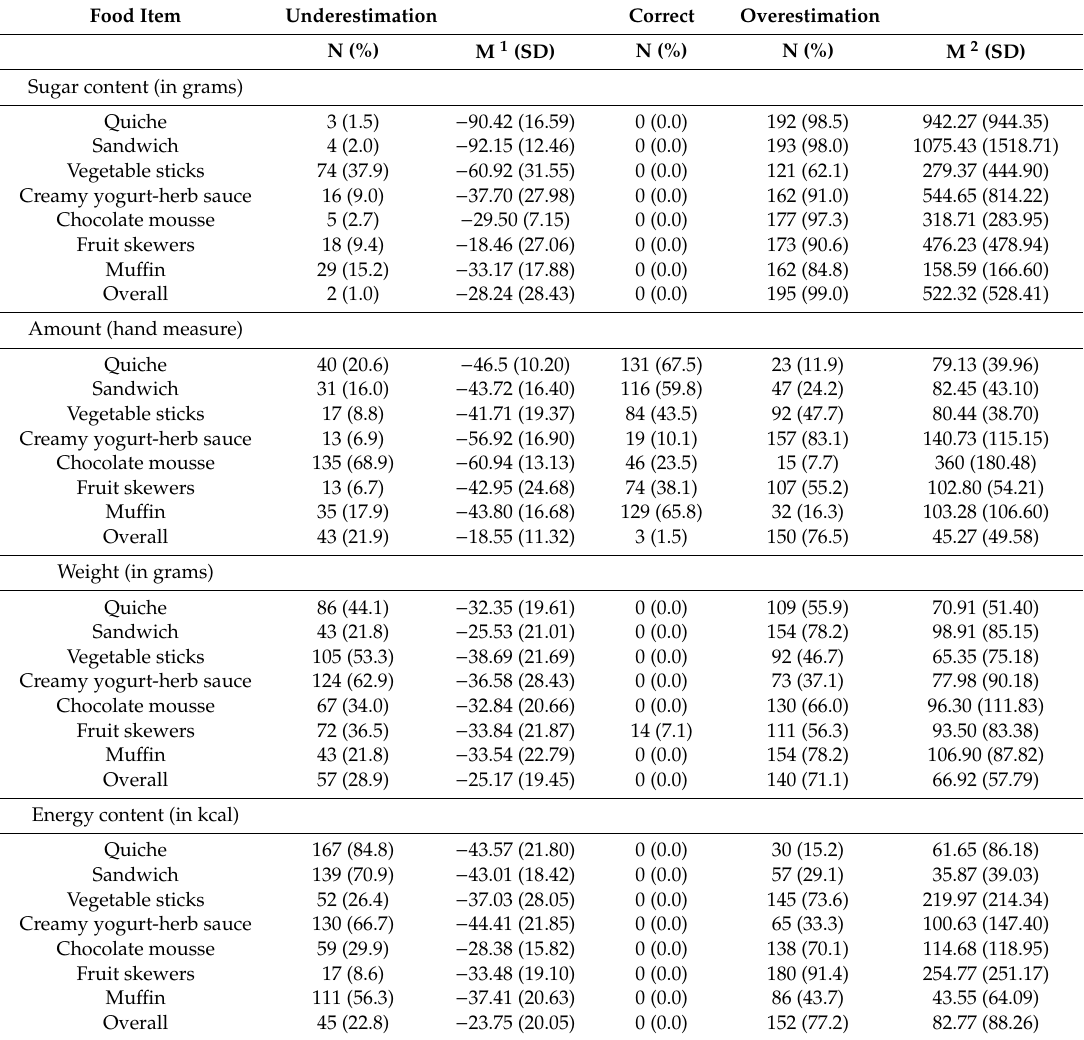
Table 2. Frequency (%) and degree ( M , SD ) of estimation errors by food type and estimation